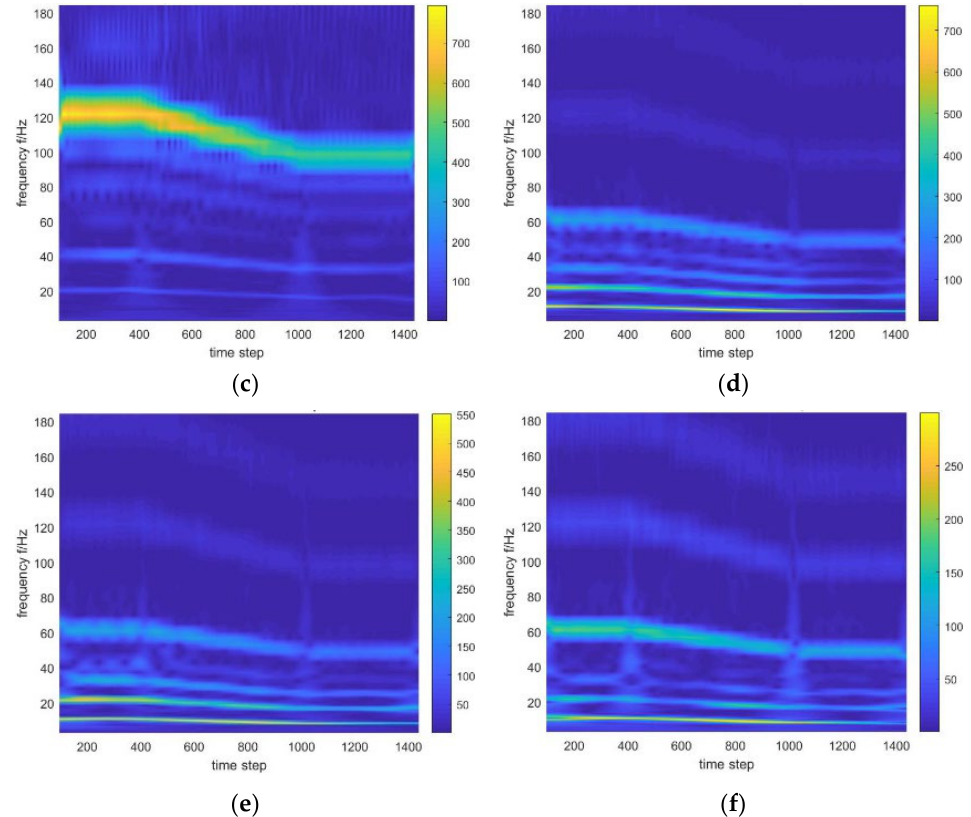
Figure 15. Frequency distribution of pressure fluctuation under two sections: ( a ) monitoring point P1 on the impeller inlet section; ( b ) monitoring point P2 on the impeller inlet section; ( c ) monitoring point P3 on the impeller inlet section; ( d ) monitoring point P4 on the guide vane outlet section; ( e ) monitoring point P5 on the guide vane outlet section; ( f ) monitoring point P6 on the guide vane outlet section.